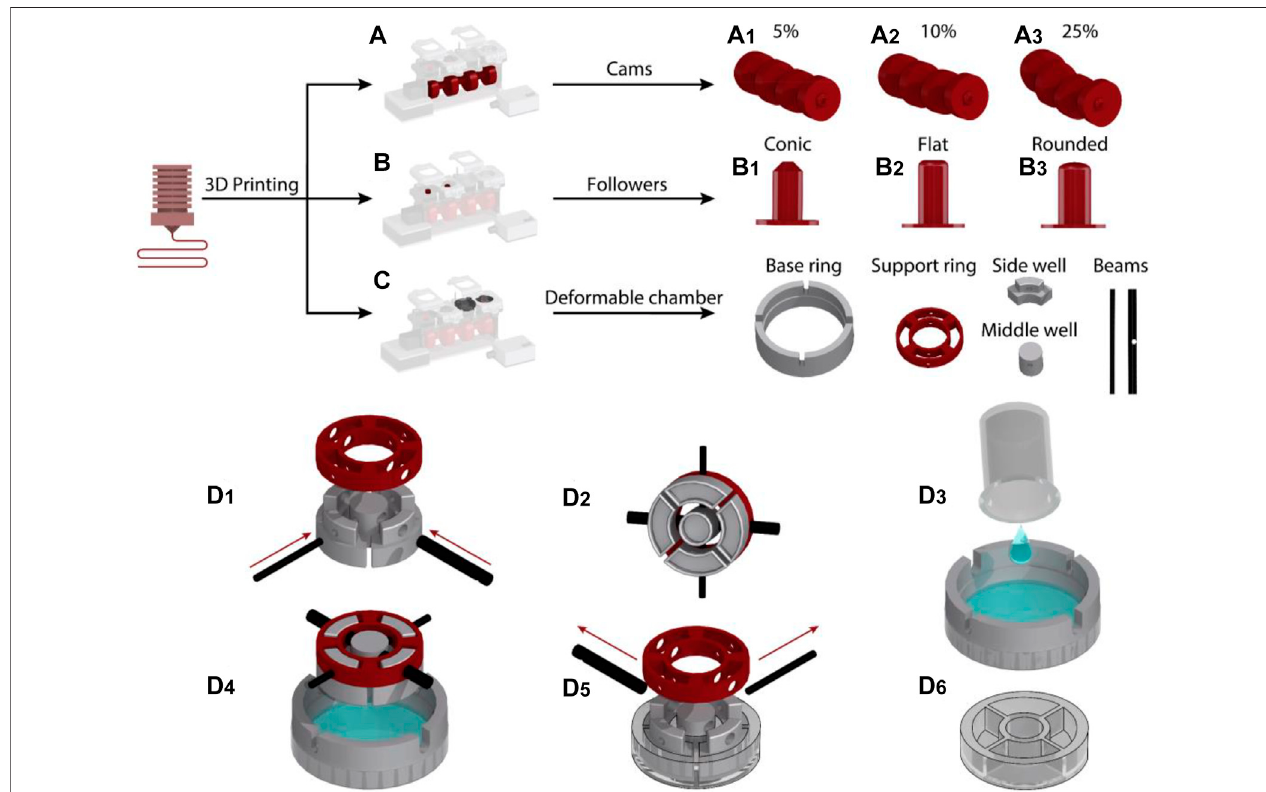
FIGURE2| Fabricationprocessofthecyclicstretchmechanism: (A) Camdesignswere3Dprintedtoinduce5,10and25%cyclicstretch. (B) Followerswithconic, round and fl at pro fi les were 3D printed. (C) Side well, middle well, beams, support ring and base ring mold pieces to fabricate the deformable cell culture chamber were 3D printed. (D) Steps for the fabrication of the deformable cell culture